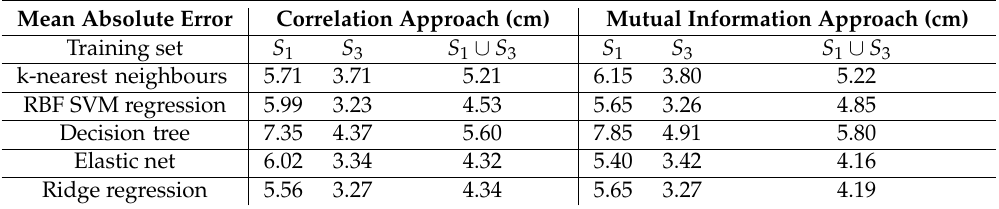
Table 8. Accuracy comparison of different training sets for the different machine learning algorithms validated on S 4 .